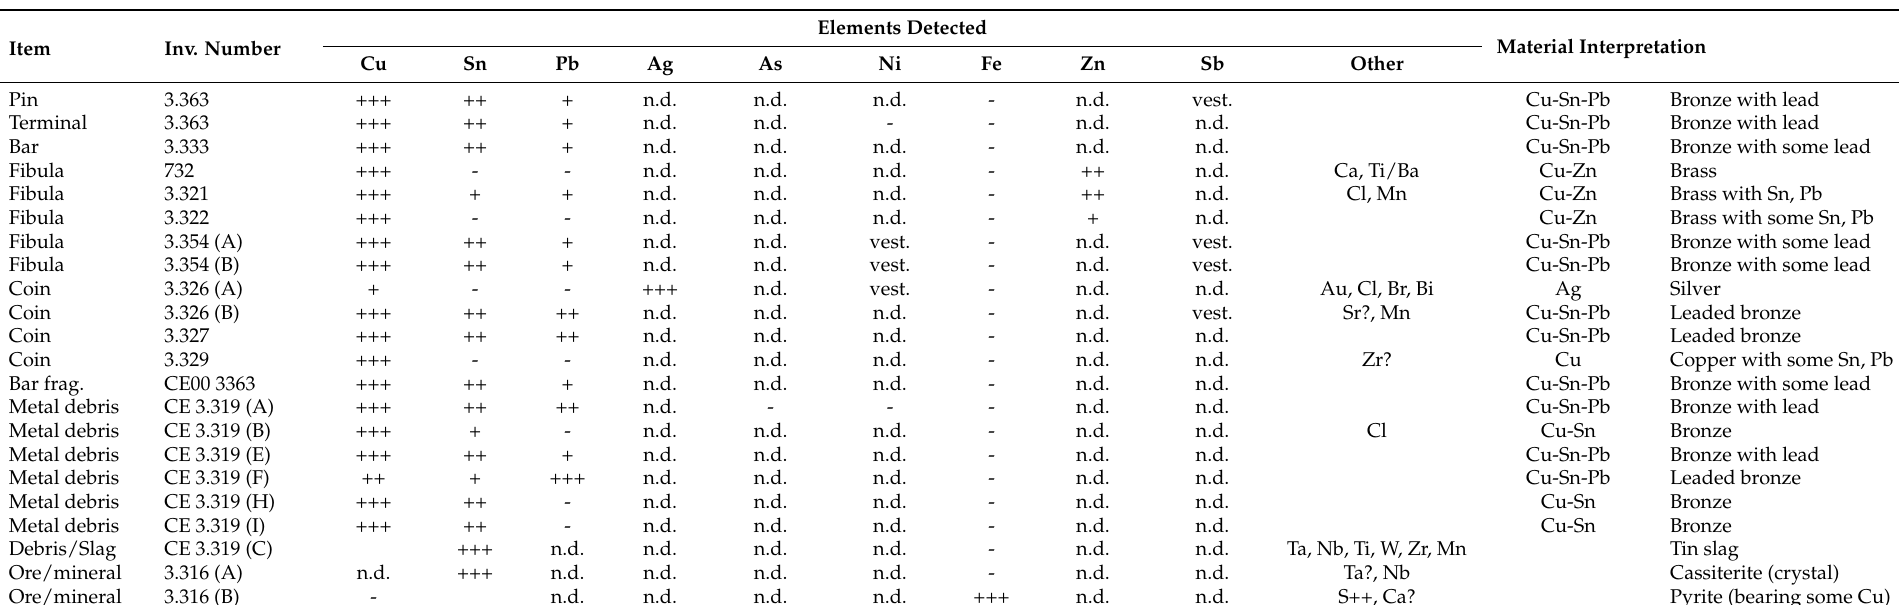
Table 1. Results from the pXRF elemental analyses (qualitative results) performed on selected artefacts from the Outeiro de Baltar hillfort collection at Museo Arqueol ó xico Provincial de Ourense (Galicia, Spain). The material interpretation takes into account normal corrosion effects in bronzes, such as decuprification, which leads to enhancement in Sn and Pb contents on the corroded surfaces